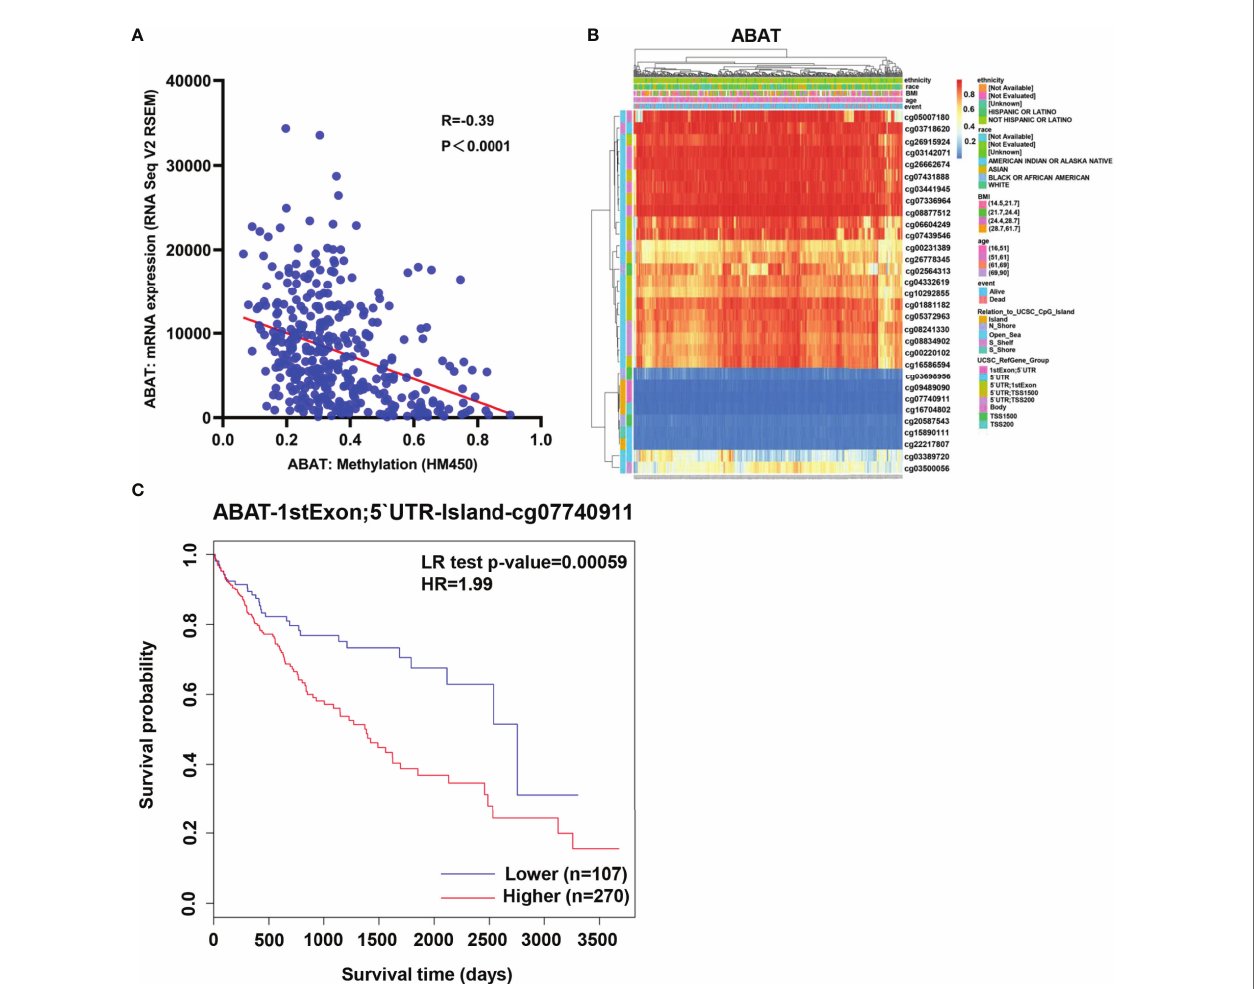
FIGURE 6 | Methylation of ABAT in HCC. (A) The correlation between ABAT methylation and its expression. (B) The visualization of the methylation level and the expression of ABAT. (C) The survival curves for promoter methylation of